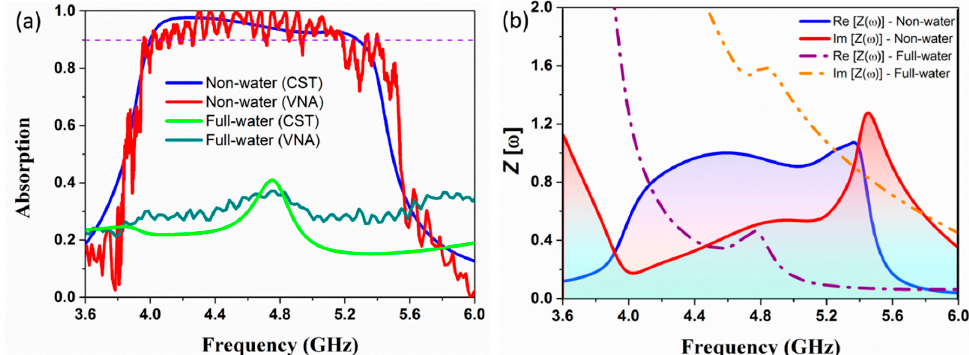
Figure 2. ( a ) Simulated (CST Microwave Studio) and measured (vector network analyzer (VNA)) absorption spectra in case of water integrated ( h = 4.0 mm) and no water ( h = 0) at 303 K. ( b ) Calculated e ff ective impedance of TCR structure for these two cases. Crystals 2020 , 10 , x FOR PEER REVIEW